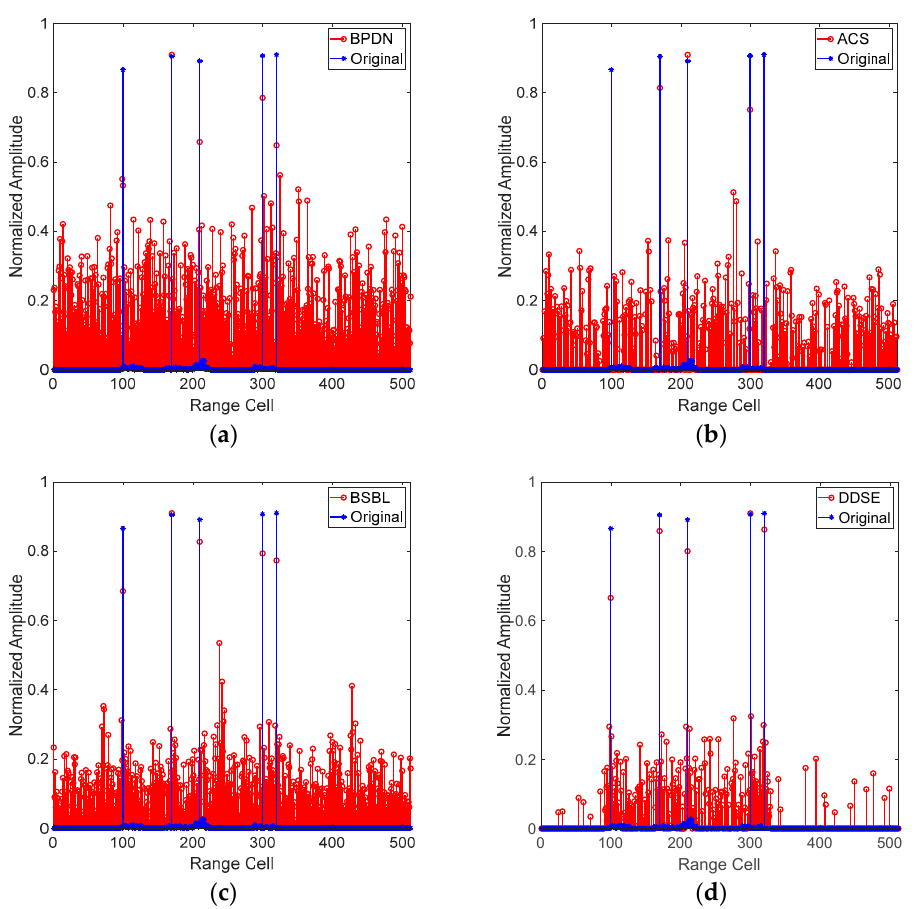
Figure 8. Range profile reconstruction based on different WBNI suppression algorithms. ( a ) basic pursuit denoising (BPDN); ( b ) adaptive compressed sampling (ACS); ( c ) block sparse Bayesian learning (BSBL); and ( d ) DDSE.